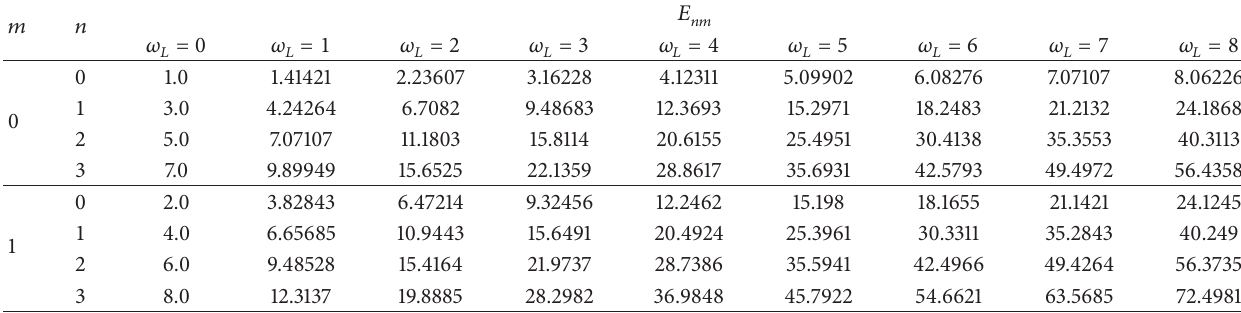
Table 3: The nonrelativistic energy eigenvalues ( 𝐸 𝑛𝑚 in atomic units) of the harmonic oscillator potential for various 𝜔 𝐿 values and 𝜉 = 0 . 𝑚